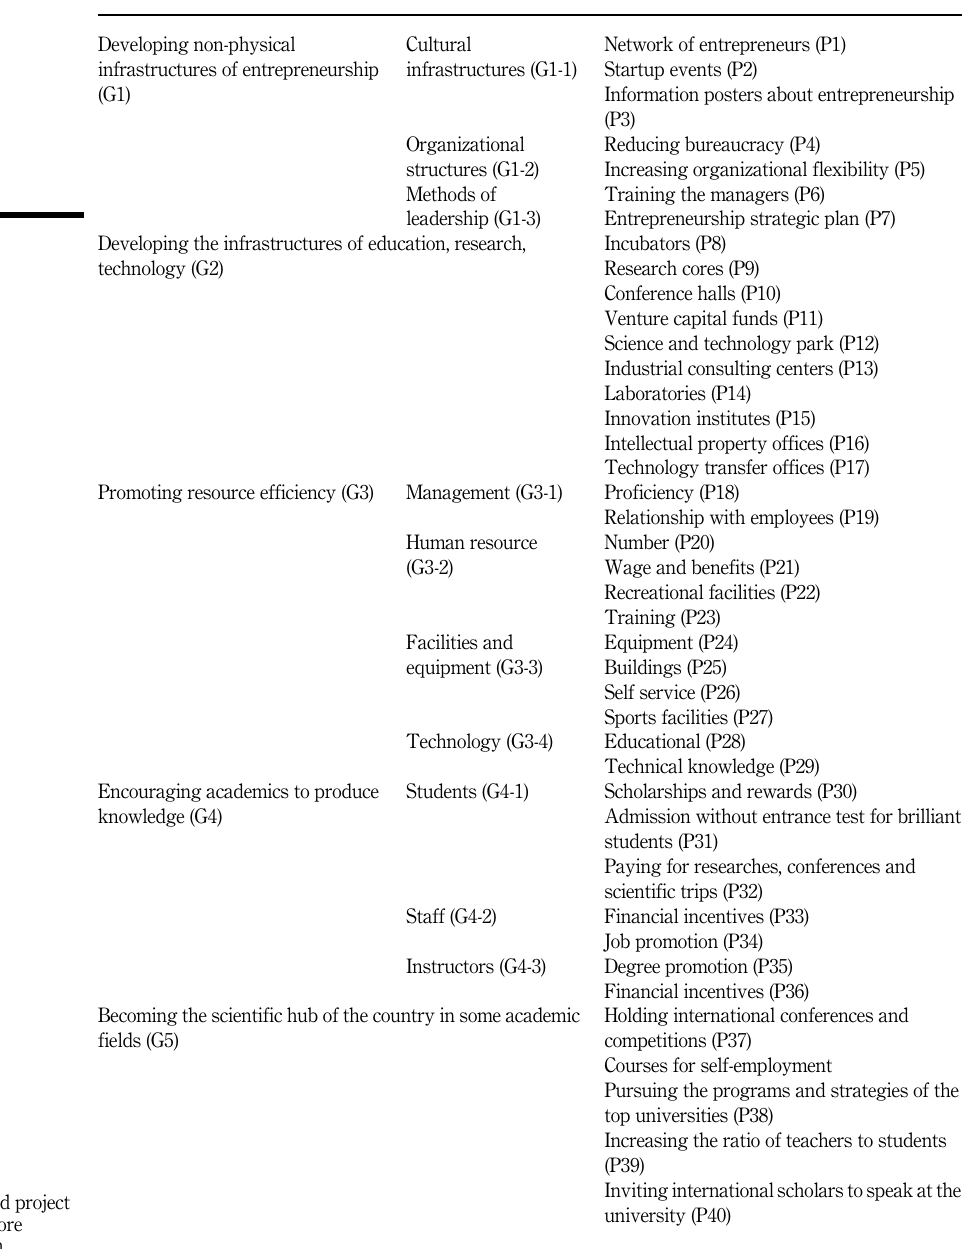
Table V. The proposed project portfolio before